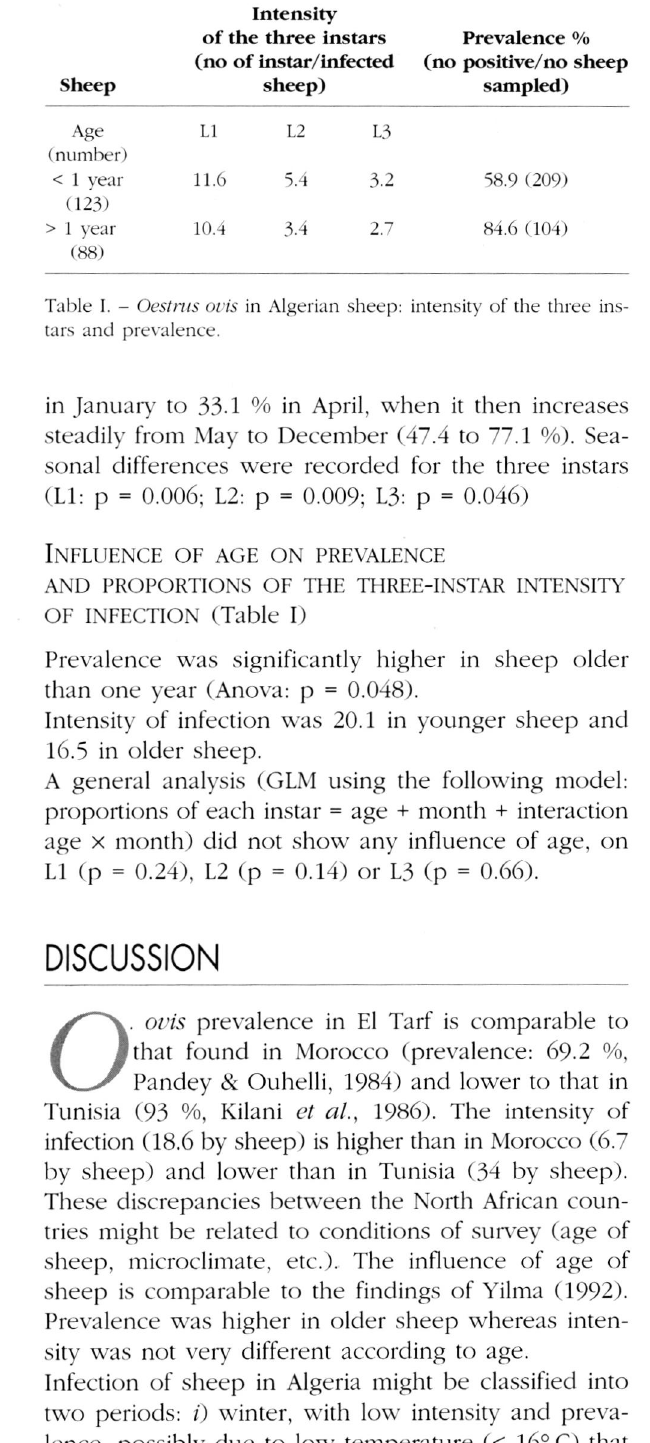
INFLUENCE OF AGE ON PREVALENCE